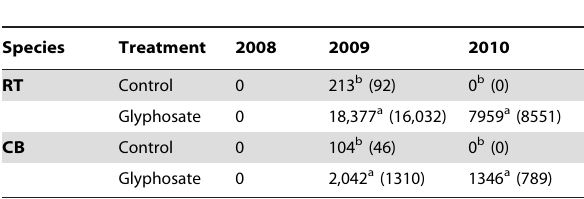
Table 3. Mean number of flowers produced by A. gigantea (RT) and A. stolonifera (CB) plants in glyphosate-treated subplots or unsprayed